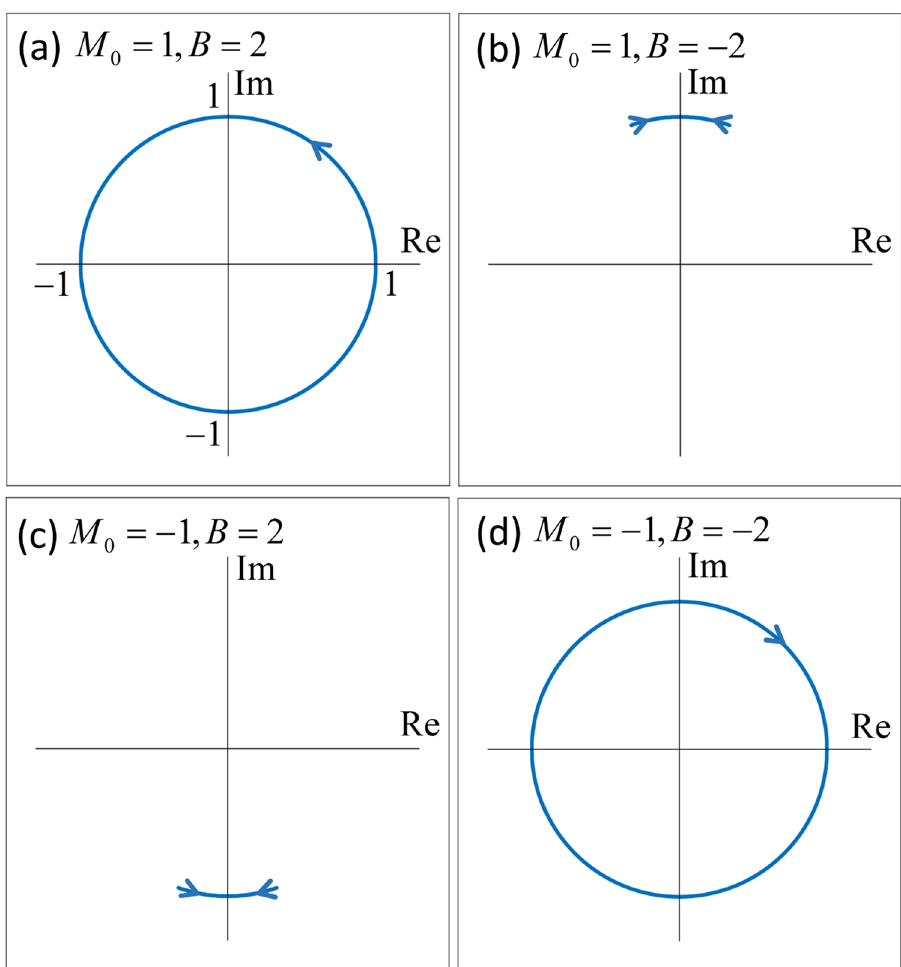
Figure 3. Trajectories of the reflection amplitudes in a cycle on the complex plane, for four different sets of ( M 0 , B ). The other parameters are taken to be the same as in Fig.